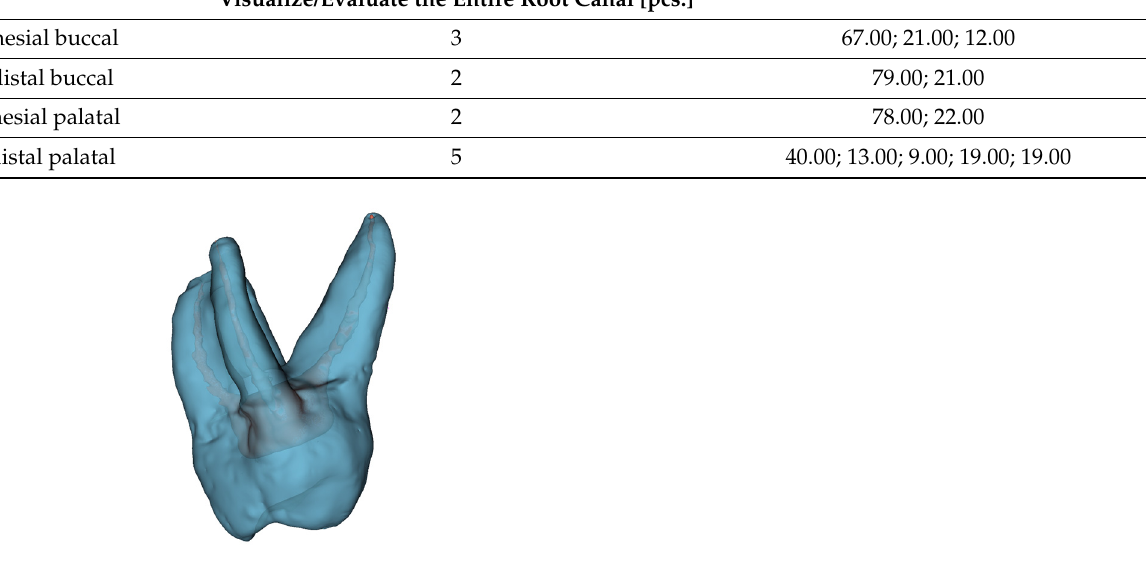
Figure 8. The 3D of tooth 17 with carious pulp